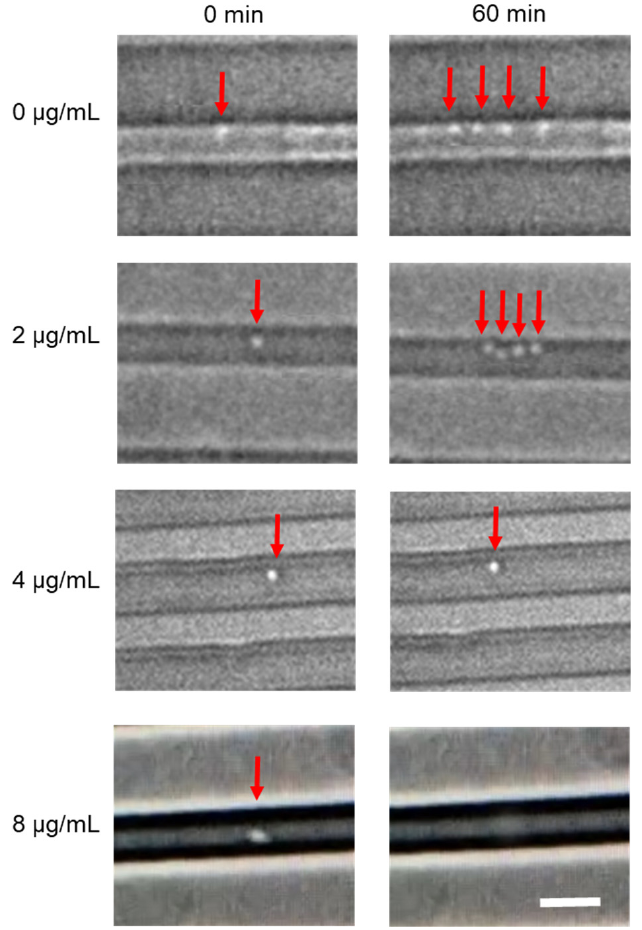
Figure 5. Phenotypic single-cell AST. Growth of isolated E. coli in single-cell microchannels with varying concentrations of ampicillin. Red arrows indicate the position of the bacteria. Growth of bacteria was observed at or below 2 µg/mL ampicillin. At 8 µg/mL, the bacterium was lysed. Scale bar, 5 µm.